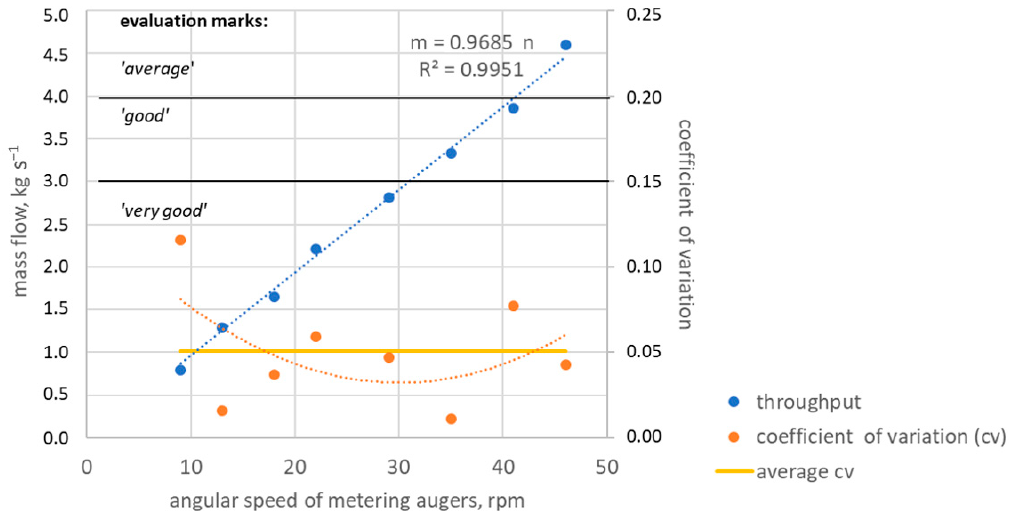
Figure 8. Mass flow versus angular speed of the metering augers and dosing quality rated by the coefficient of variation according to DLG test framework.